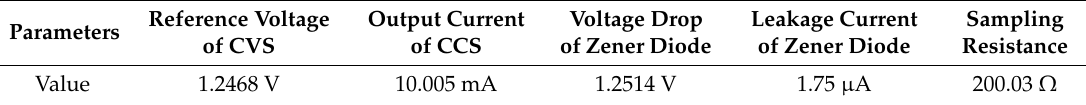
Table 4. Parameters used in the simulation model.